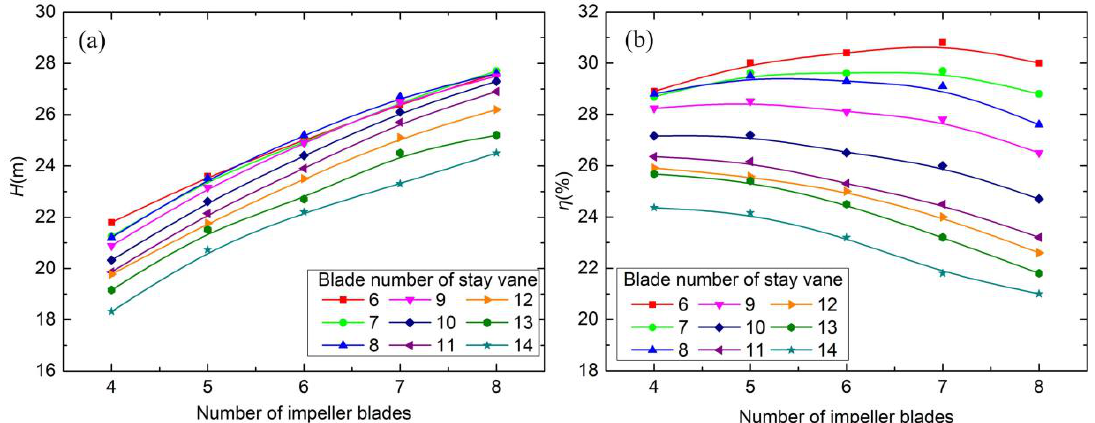
Figure 8. ( a ) Head and ( b ) efficiency under a different number of impeller blades.